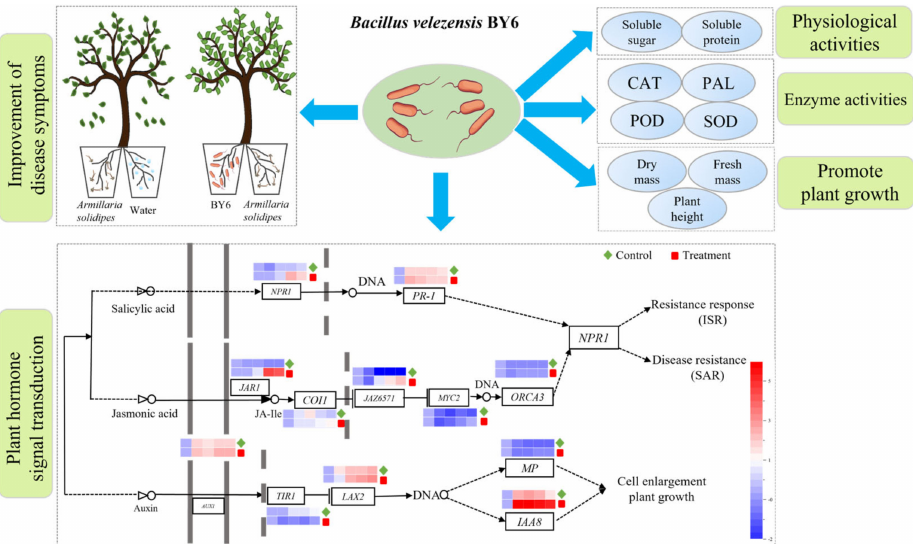
Figure 6. Schematic representation of the growth-promoting and disease-resistant responses of BY6 to diseased Pdpap poplar after induction. SA pathway genes ( NPR1 ; PR-1 ). JA pathway genes ( JAR1 ; COI-1 ; JAZ6571 ; MYC-2 ; ORCA-3 ). Auxin pathway genes ( AUX1 ; TIR1 ; LAX2 ; MP ; IAA8 ). Color bar: the red part represents genes with positive expression levels, and the blue represents negative expression levels. The roots of Pdpap poplar seedlings were divided into two equal parts (part 1 and part 2), and transplanted solid and dashed arrows indicate direct and indirect activation,